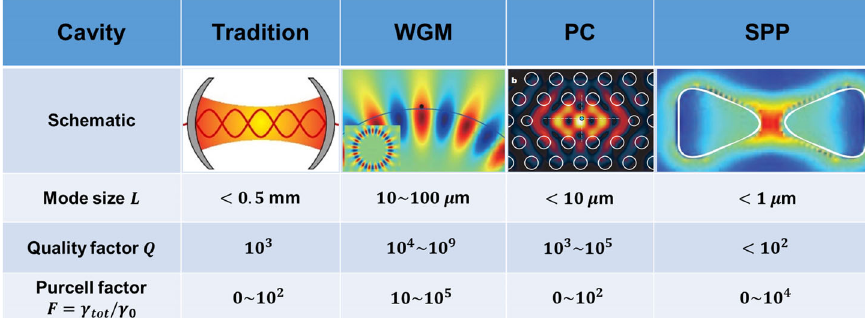
Table 1 Schematic, mode size L , quality factor Q , and Purcell factors F = γ tot /γ 0 for traditional